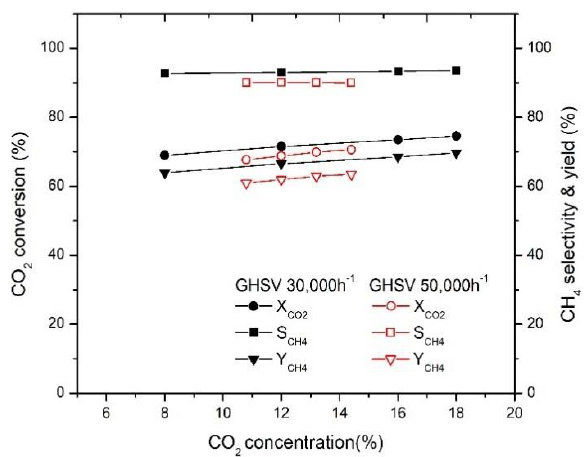
Figure 5. Effect of reactant concentration (CO 2 concentration = CO 2 /(H 2 + CO 2 + N 2 )) at a reaction temperature of 350 °C.